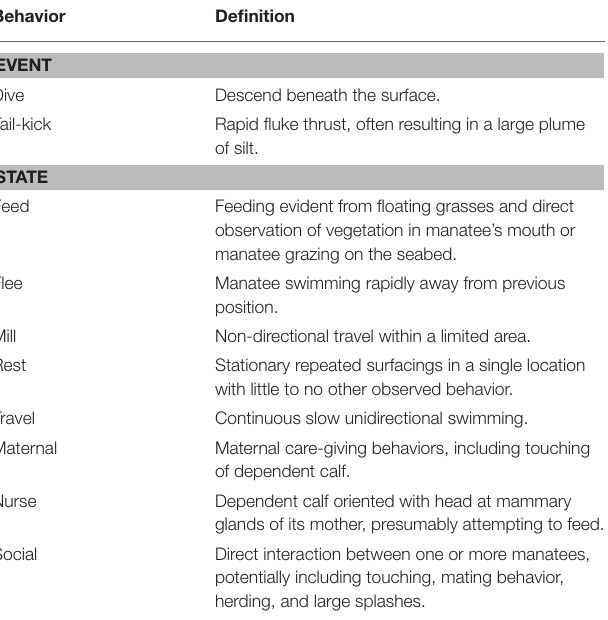
TABLE 2 | Ethogram of the different behaviors of Antillean